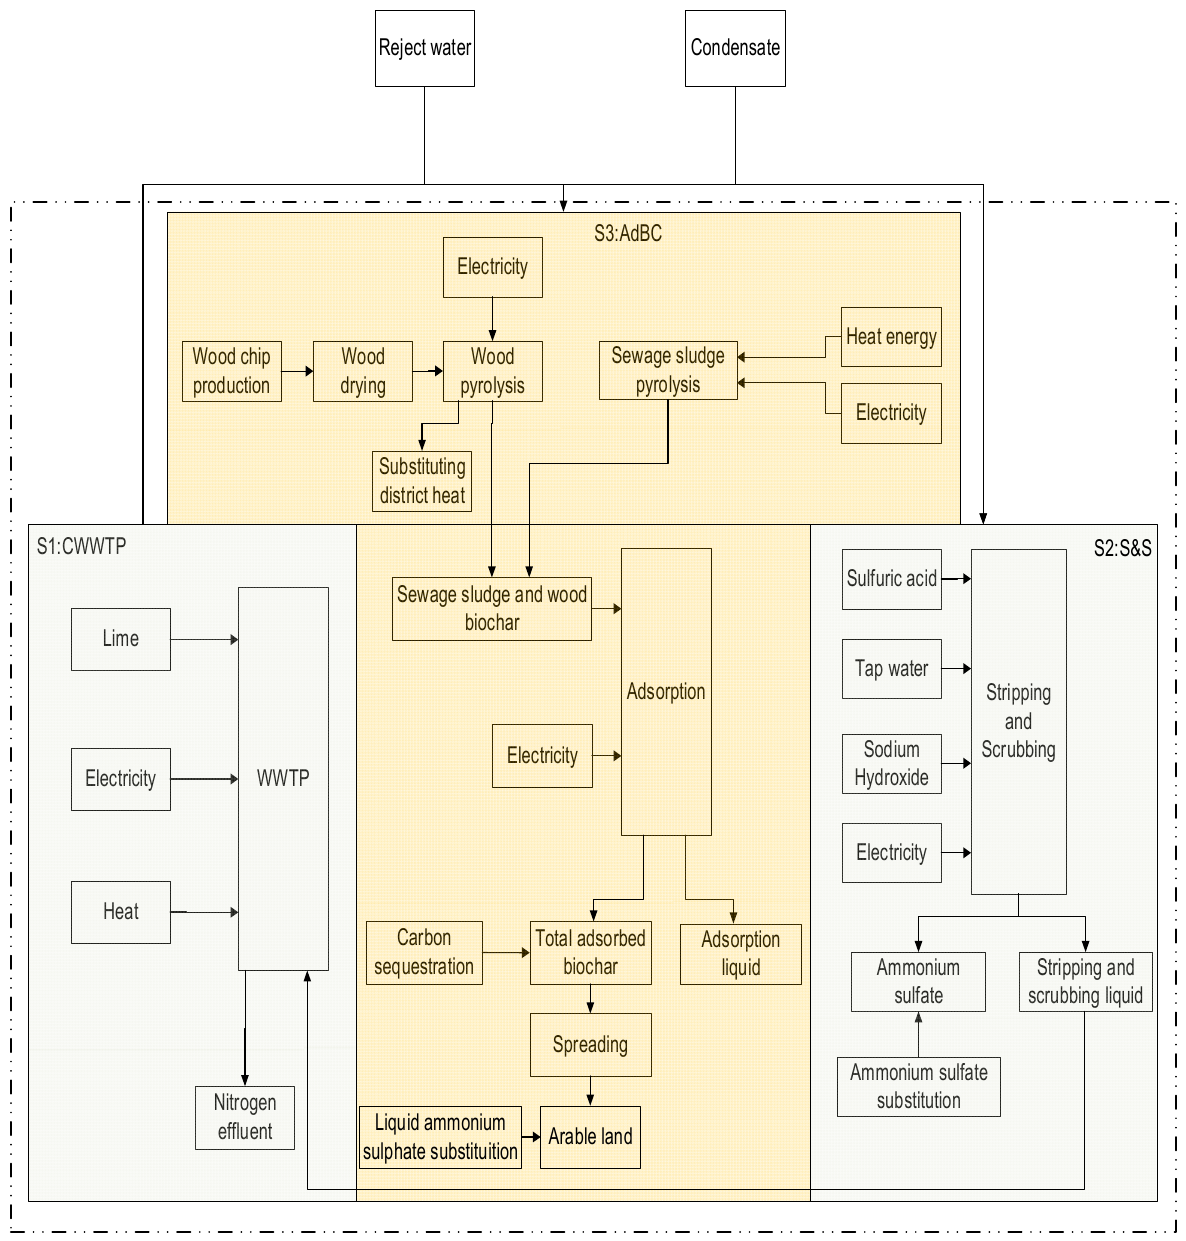
Figure 3. System boundaries and processes in each scenario.